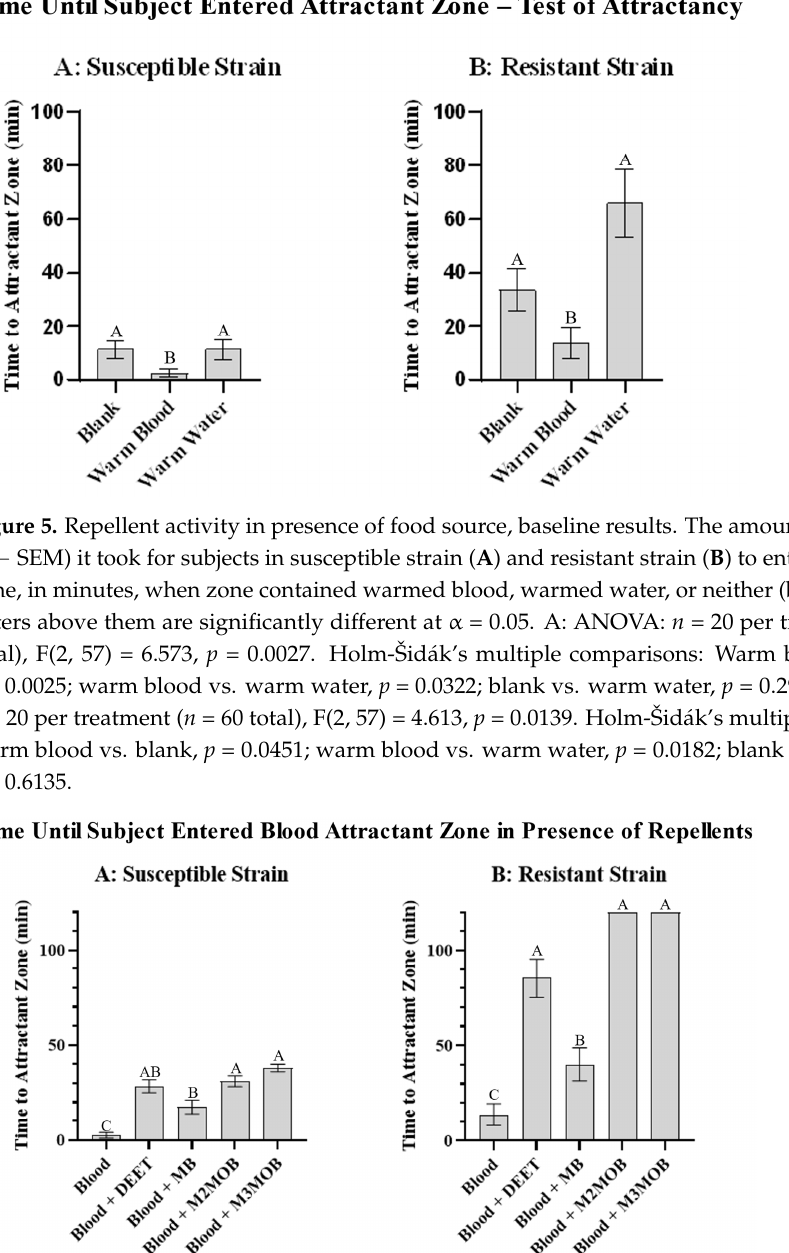
Figure 6. Repellent activity in presence of food source. The amount of time (mean +/ − SEM) it took for subjects in susceptible strain ( A ) and resistant strain ( B ) to enter the blood attractant zone, in minutes, when zone is surrounded by a repellent compound [0.14 μ L/cm 2 of DEET, methyl benzoate (MB), methyl 2-methoxybenzoate (M2MOB), or methyl 3-methoxybenzoate (M3MOB)]. Error bars are not shown for M2MOB and M3MOB of the resistant strain because all subjects went the entire 120 min without entering the attractant zone for both treatments. Different letters above them are significantly different at α = 0.05. A: ANOVA: n = 20 per treatment ( n = 100 total), F(4, 95) = 27.07, p < 0.0001. Holm-Šidák’s multiple comparisons: Control vs. any other treatment, p < 0.0001; MB vs. M2MOB, p = 0.0294; MB vs. M3MOB, p = 0.0083; all other comparisons not significant. B: ANOVA: n = 20 per treatment ( n = 100 total), F(4, 95) = 11.77, p < 0.0001. Holm-Šidák’s multiple comparisons: Control vs. DEET, p < 0.0001; Control vs. MB, p = 0.0011; Control vs. M2MOB, p < 0.0001; Control vs. M3MOB, p < 0.0001; DEET vs. MB, p = 0.0442; MB vs. M2MOB, p = 0.0001; MB vs. M3MOB, p = 0.0001; all other comparisons were not significant.